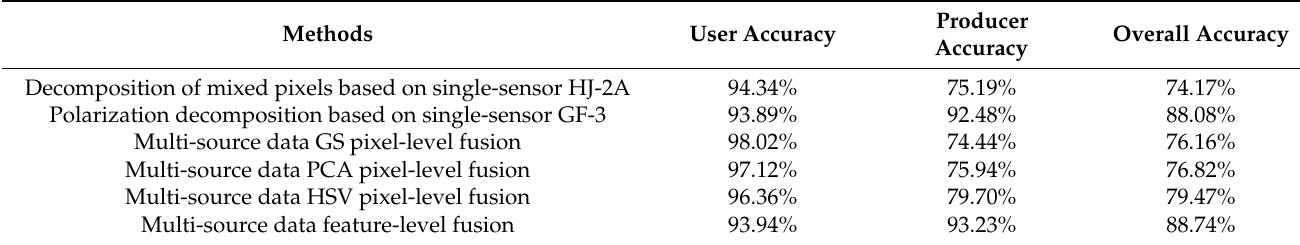
Table 6. The accuracy of sandy land detection based on a Google Earth image. Methods